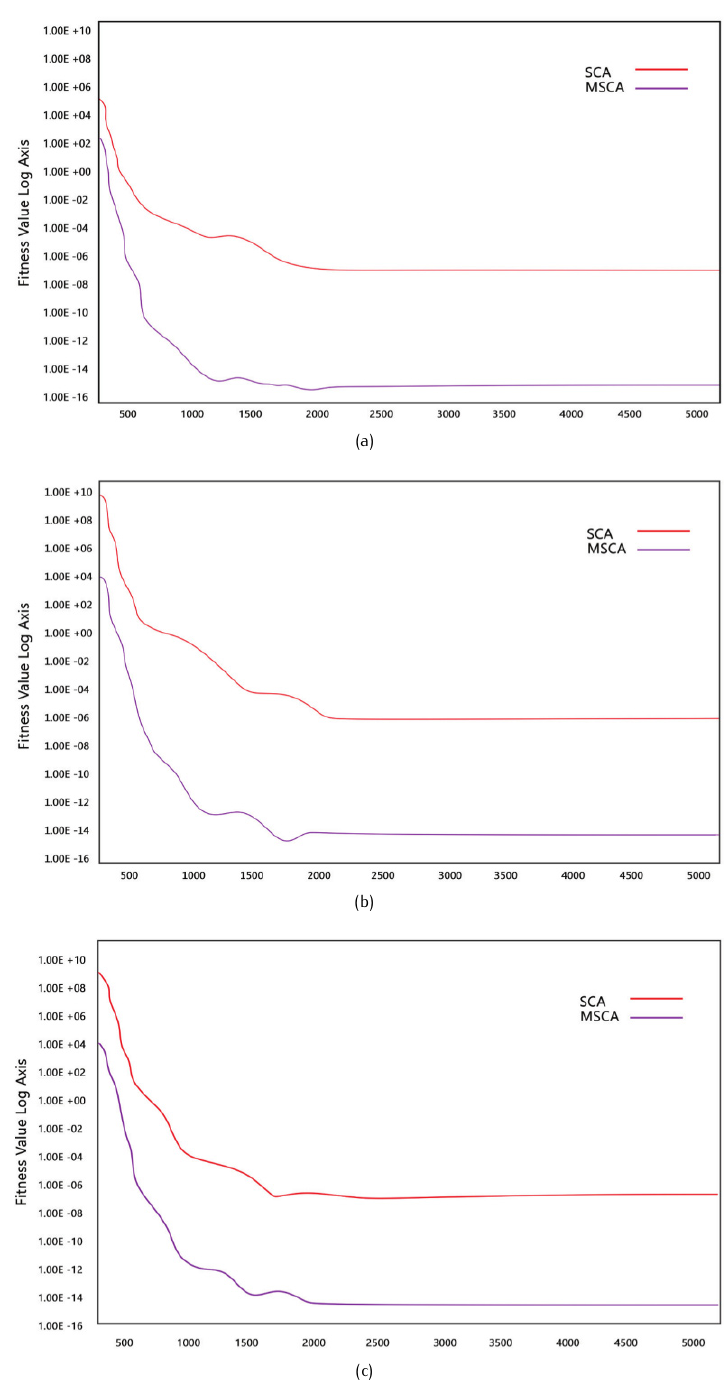
Figure 9. ComparisonbetweenSCAandMSCAwithdifferentparametersvaluesonQuartic